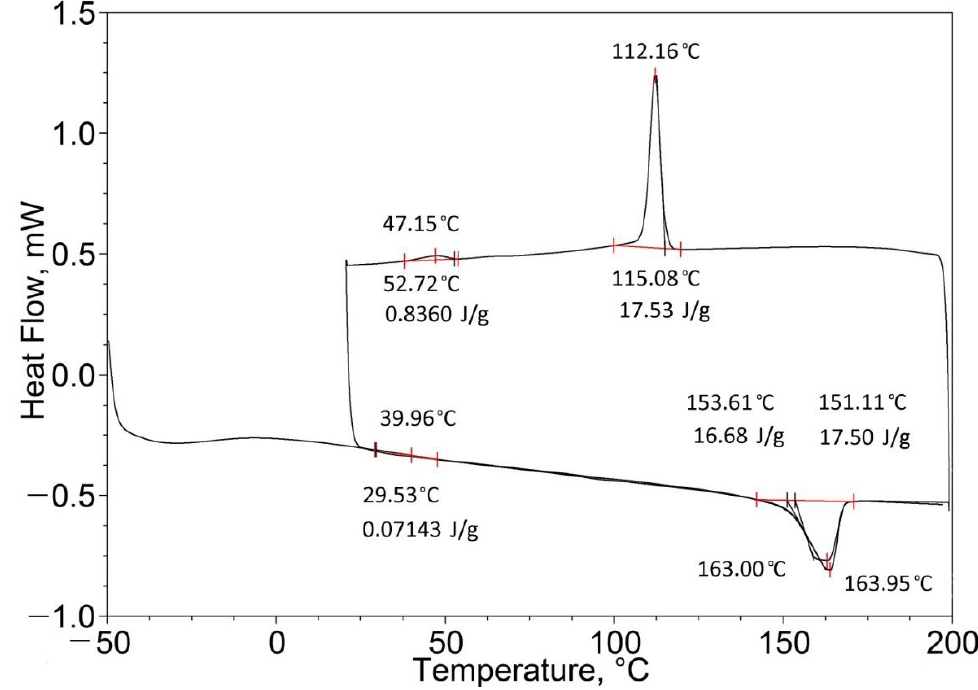
Figure 11. Melting-crystallization-melting diagram (DSC scan curves) of the 25% PP-75% EPTSR polymer blend produced by melt blending